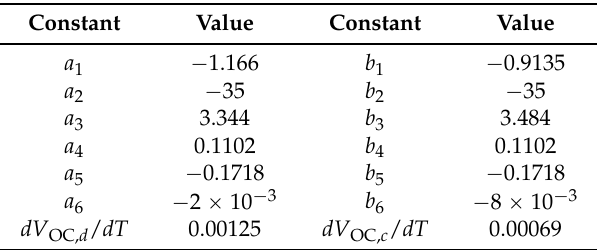
Table 3. V OC parameter